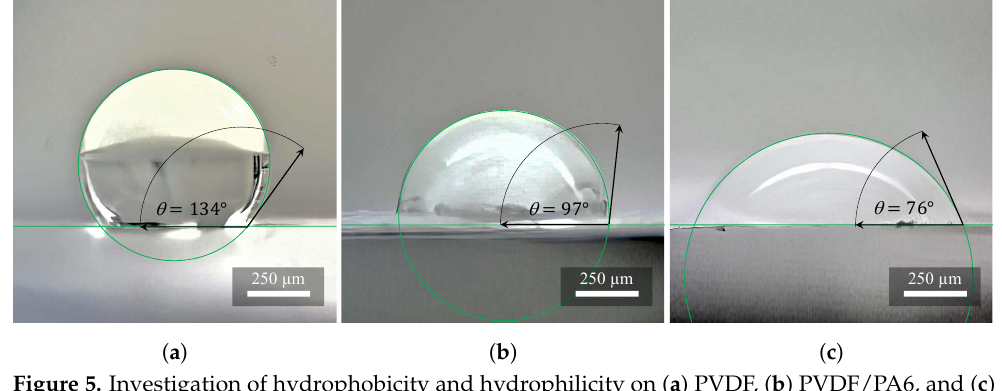
Figure 5. Investigation of hydrophobicity and hydrophilicity on ( a ) PVDF, ( b ) PVDF/PA6, and ( c ) PA6. The wettability of the samples increases with higher nylon concentration. These are average values from ten measurements.